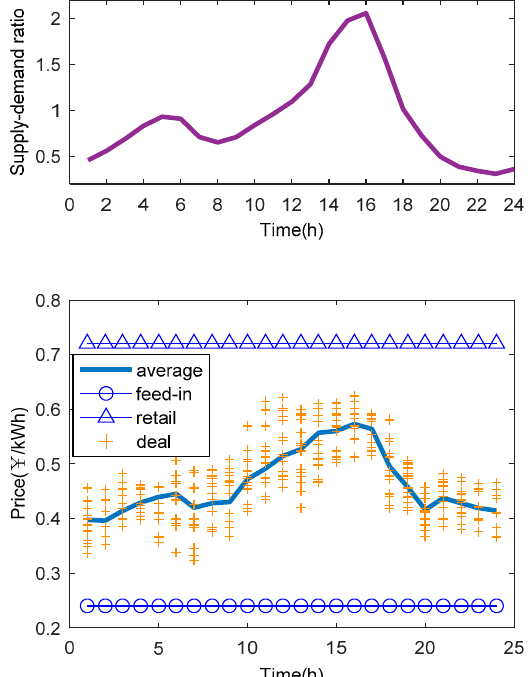
Figure 8. The relationship between deal prices and supply demand ratio of